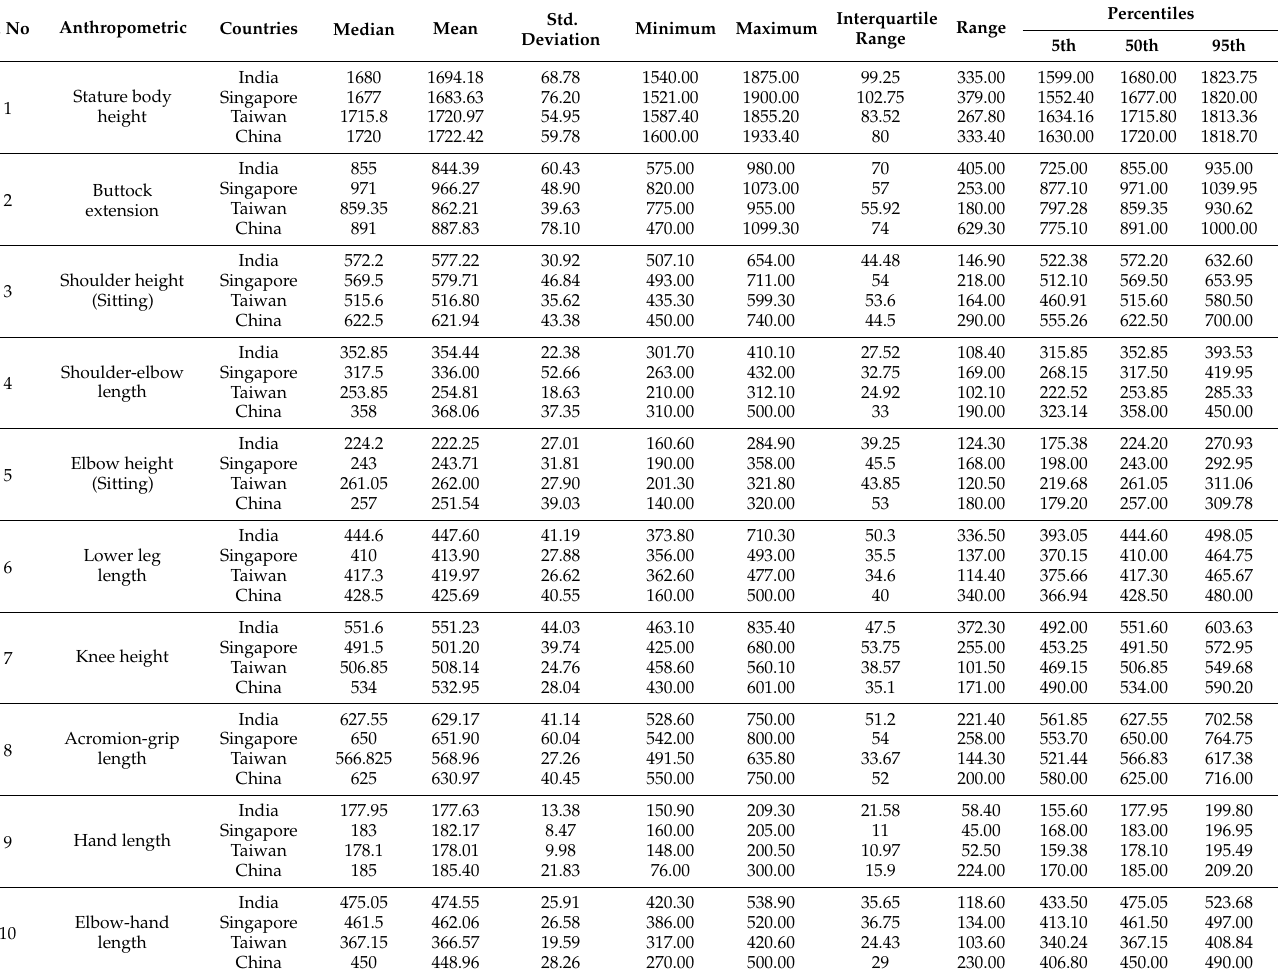
Table 2. Descriptive statistics of cyclists’ anthropometric measurements. Note: All measurements are in mm unless